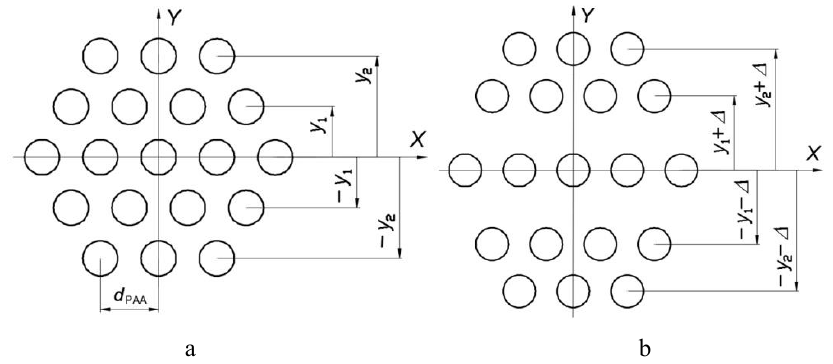
Fig. 2. Placement of radiators in the antenna array in the absence of basing errors (a) and presence of basing errors